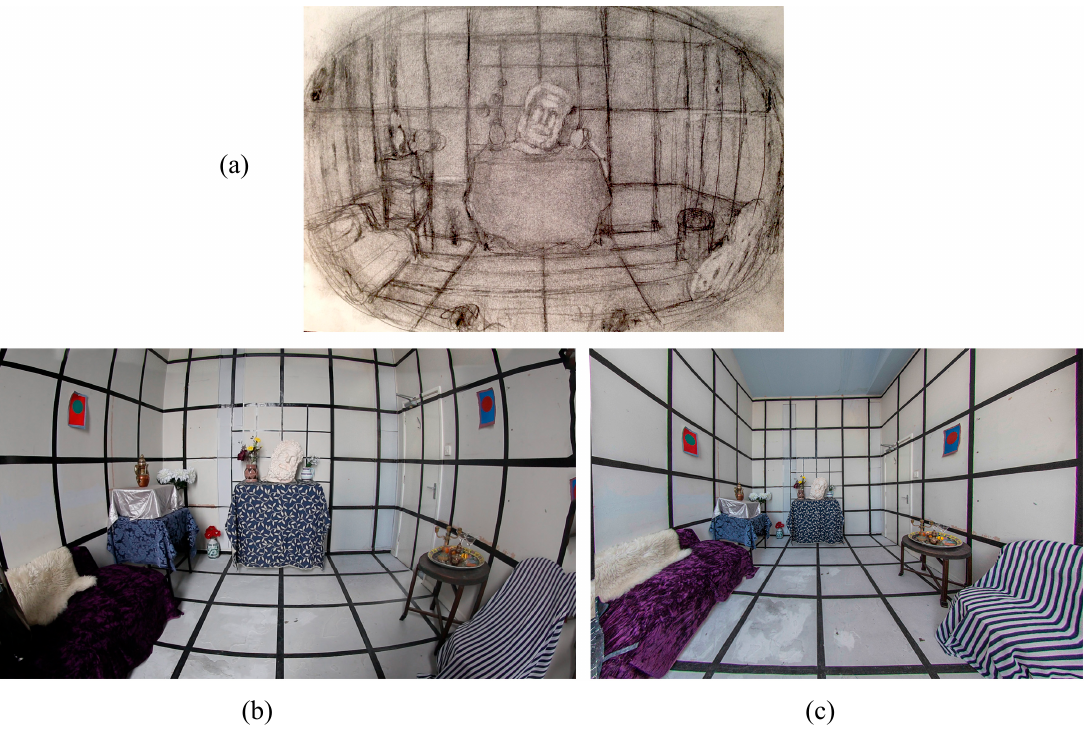
Figure 2. An illustration of the difference between the pictorial organization of an artistic depiction of a three-dimensional scene ( a ), a fisheye photographic image ( b ) and a linear perspective photographic image ( c ) of the same scene from the same point of view, centered on the plaster head. Each image depicts approximately the same field of view. The artistic view of the left can be considered a map of the structure of the visual space while the photographs capture in different ways the optical data.